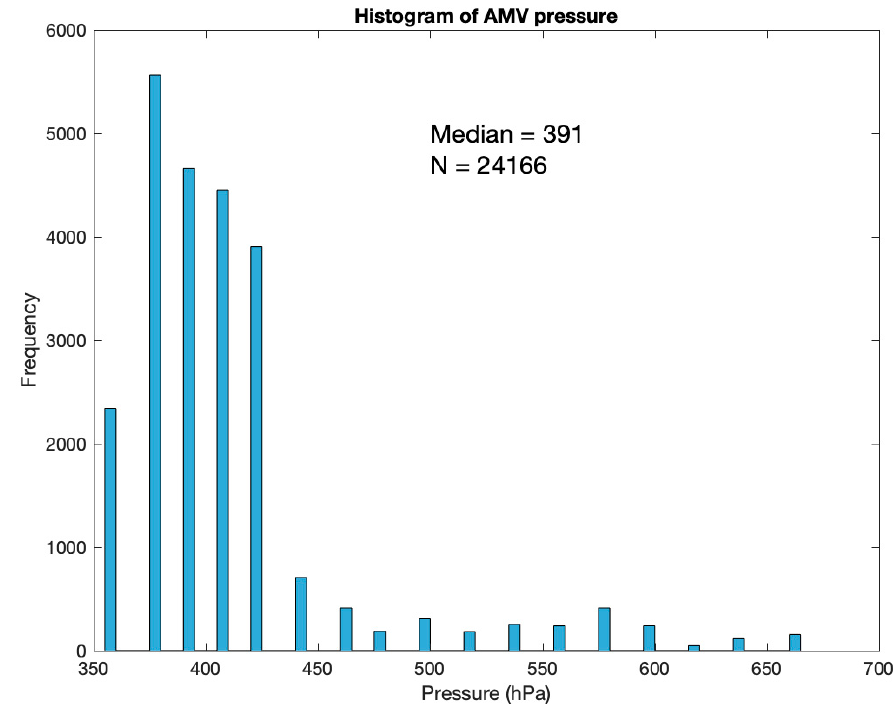
Figure 7. Histogram of the pressures for co-located Aqua MODIS and AIRS retrieval AMVs for a northern hemisphere summer case: 14 June to 31 July 2012. Since both the AIRS and MODIS AMVs are on discrete (but di ff erent) pressure levels, the resulting histogram is depicted of discontinuous frequency bars, at the AIRS AMV pressure levels, which are approximately every 16 hPa from 359 to 424 hPa. The MODIS AMVs are assigned pressures to the nearest 12.5 hPa.